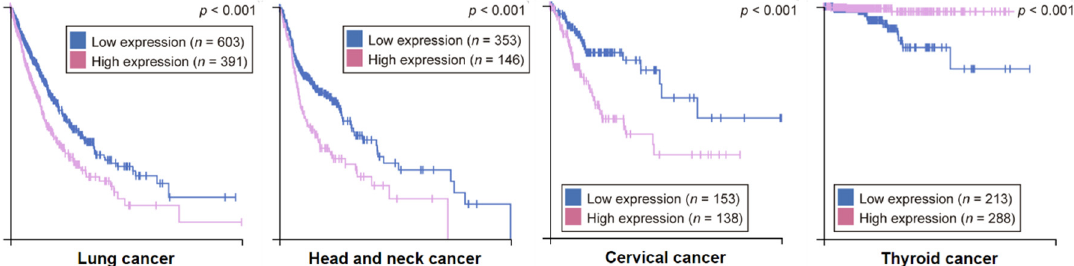
Figure 8. Kaplan-Meier plots for cancer types where high FADD expression has significant ( p < 0.001) association with patient survival. Based on the FPKM value, patients were divided based on FADD mRNA level into one of the two groups “low” (under cutoff) or “high” (over cutoff). The X -axis shows time for survival (years) and the Y -axis shows the probability of survival, where 1.0 corresponds to 100 percent. The prognosis of each group of patients was examined by Kaplan-Meier survival estimators, and the survival outcomes of the two groups were compared by log-rank tests. (From The Human Protein Atlas).